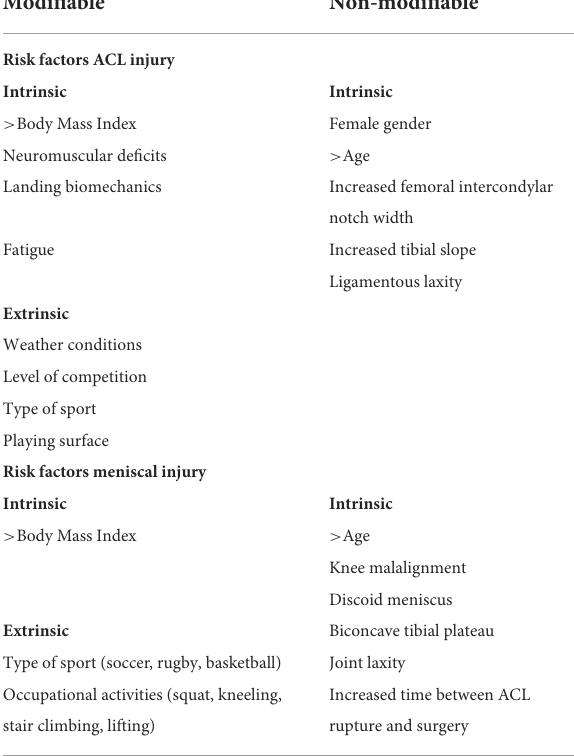
TABLE 1 Risk factors for ACL injury and meniscal